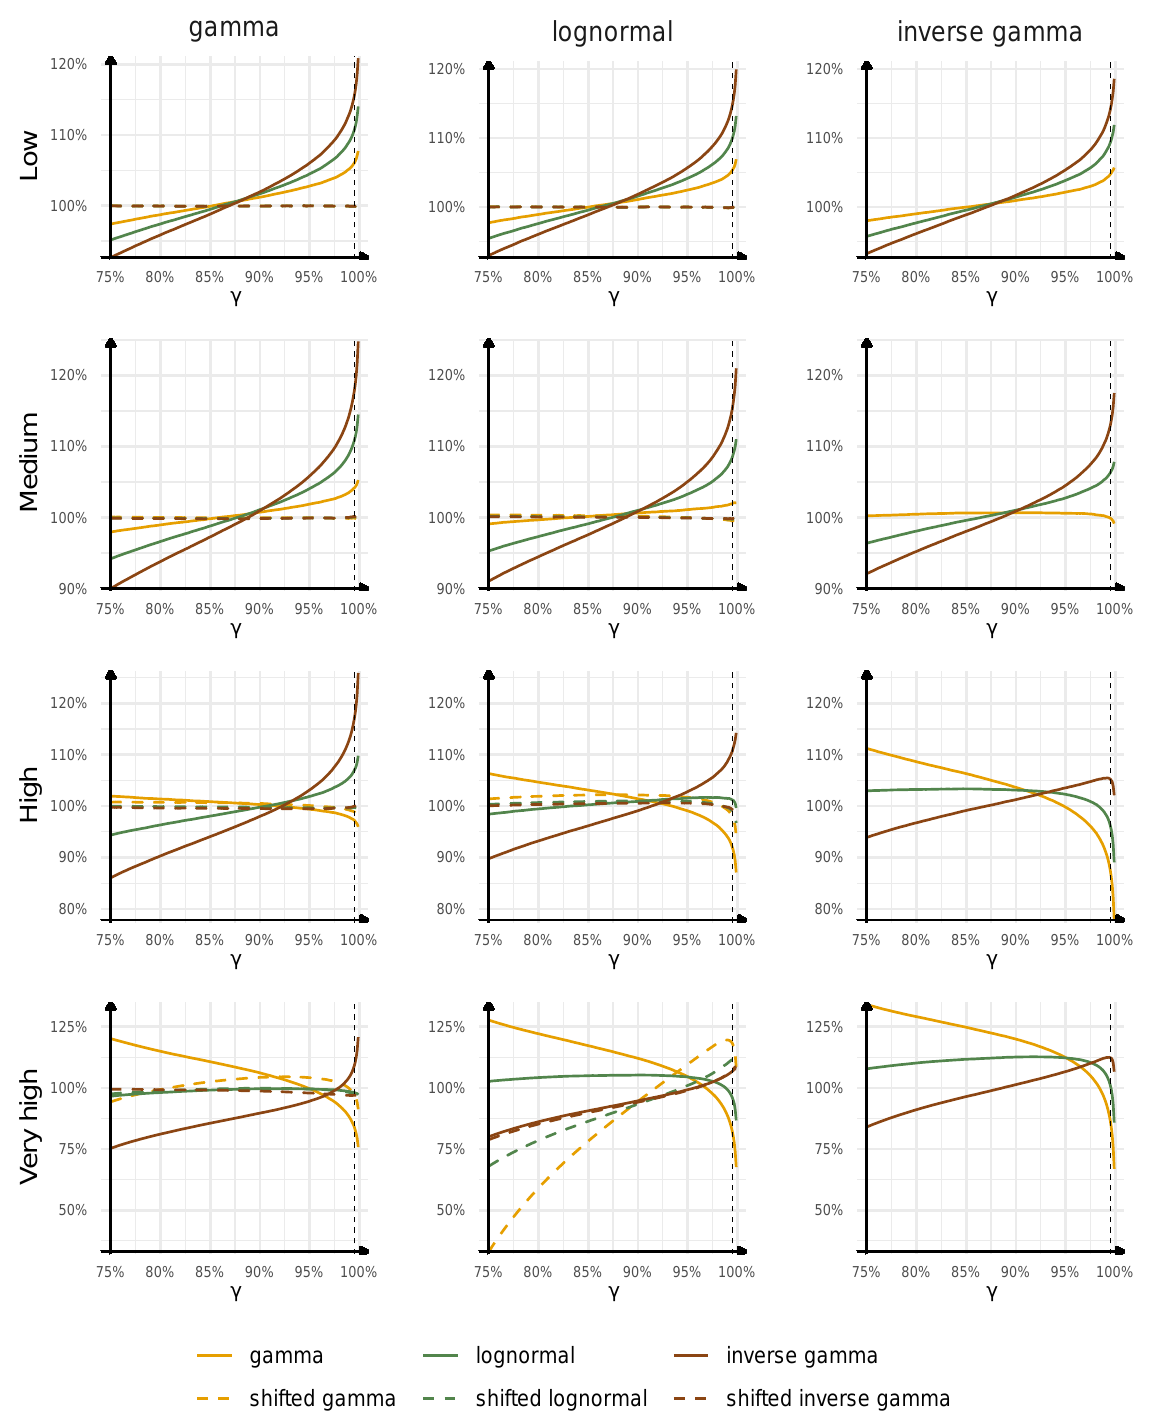
Figure 4. The ratios of Value-at-Risk measures for the outstanding loss estimated with parametric distribution and empirical distribution as a function of the confidence level—the case with the estimation error and the ultimate